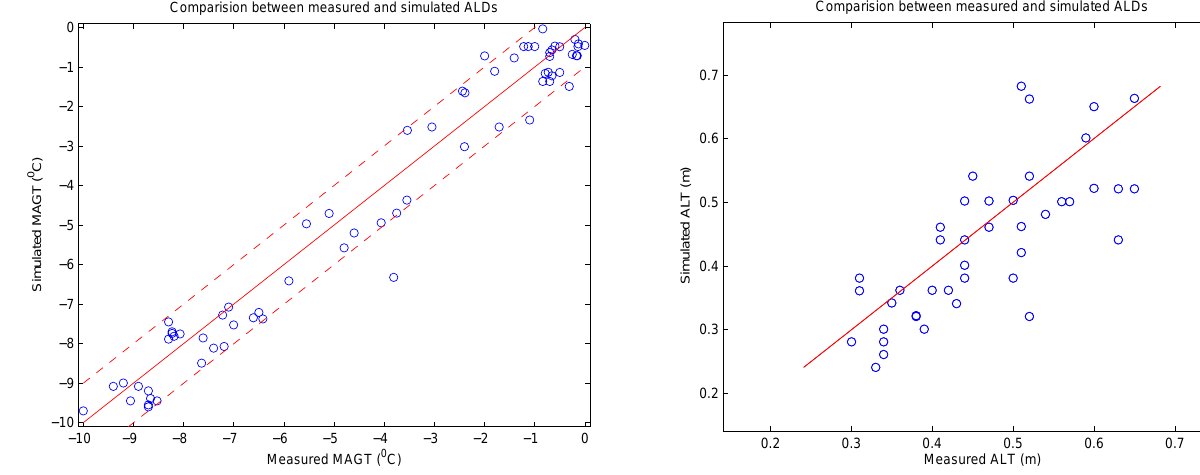
Fig. 7. Comparision between simulated and observed ALTs from 43 CALM observation